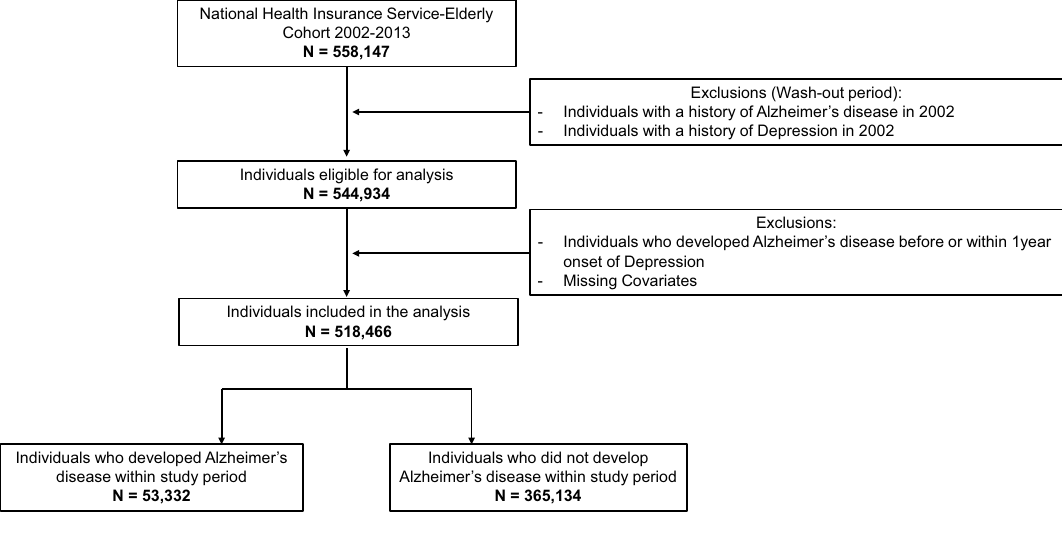
Figure 1. Flowchart of the participant